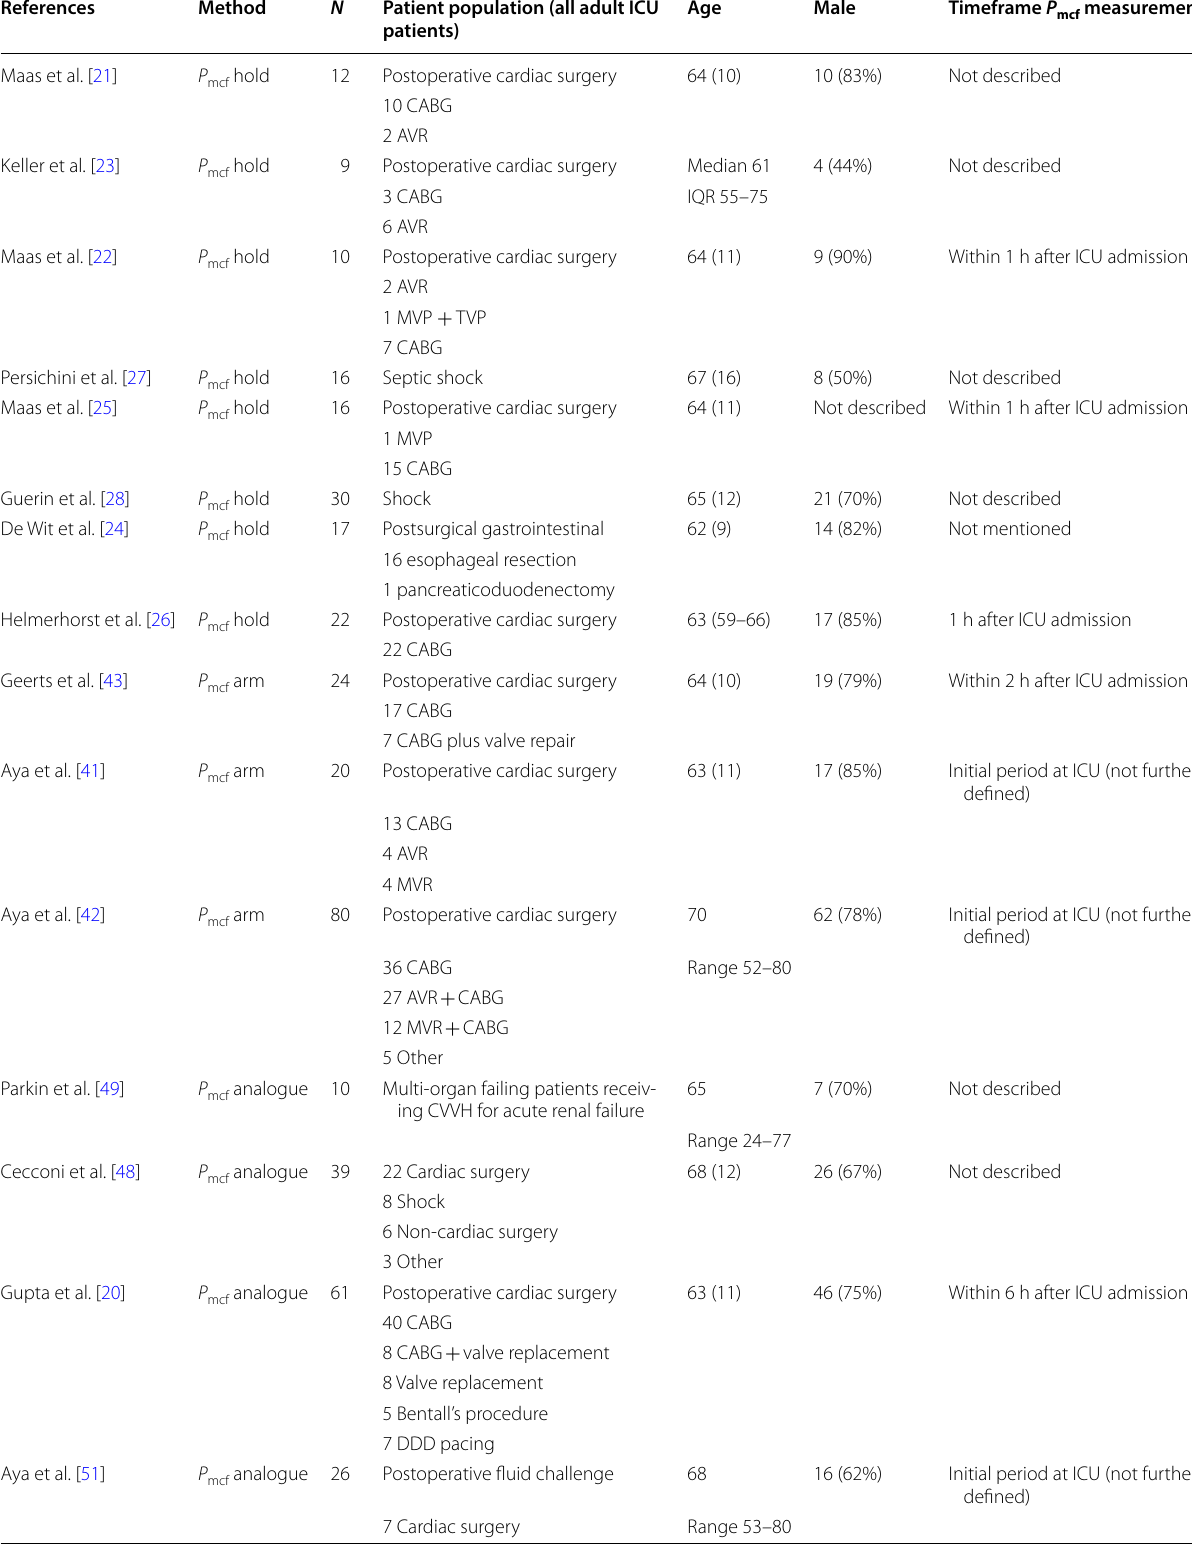
Table 1 Baseline characteristics for included